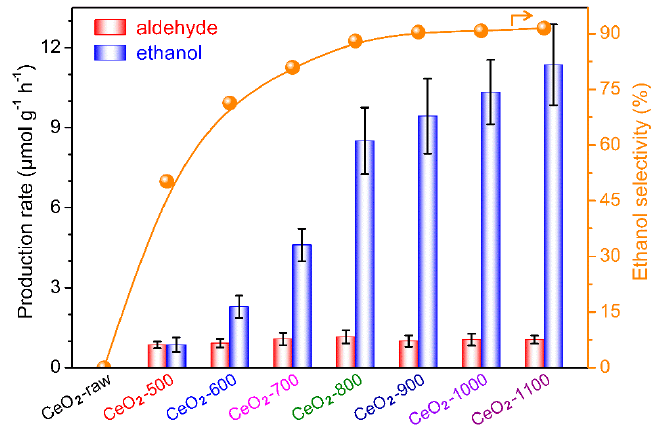
Figure 6. Production rates of the photocatalytic products aldehyde (CH 3 CHO) and ethanol (CH 3 CH 2 OH) over CeO 2 -raw and CeO 2 -x photocatalysts under simulated sunlight irradiation. The ethanol selectivity is shown with orange dots.